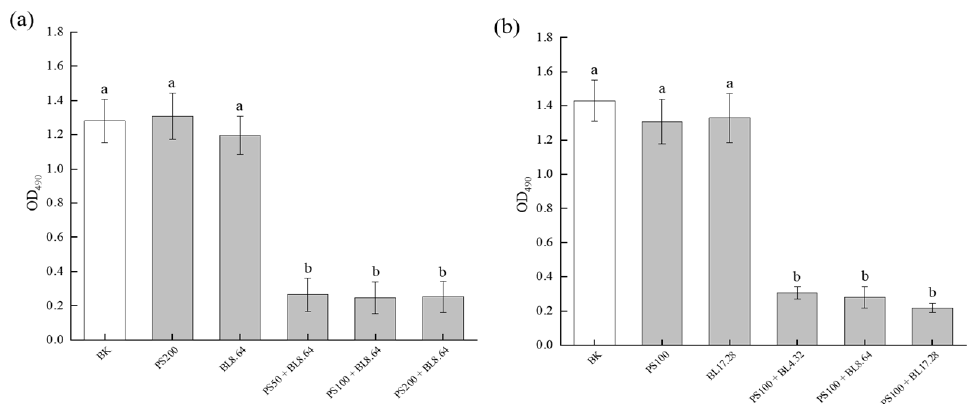
Figure 3. Effect of PDI on S. saprophyticus biofilm metabolic activity under different curcumin concentration ( a ) and light dose ( b ). BK: blank control; PS: photosensitizer treatment; BL: blue-light treatment; PS + BL: photosensitizer combined blue-light treatment. Values are presented as mean ± SD. Different letters indicate significant difference between the test samples ( p < 0.01).